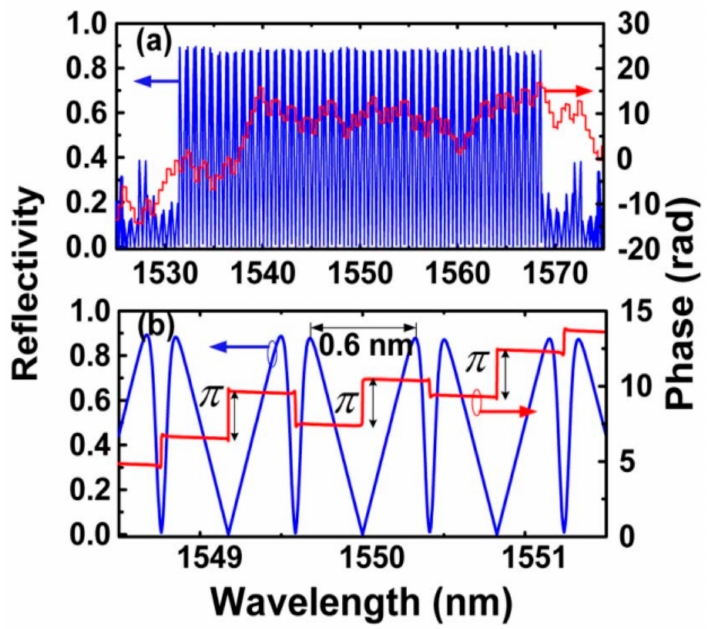
Figure 24. The designed results of the 45-channel first-order temporal differentiator based on a phase-only sampled FBG. ( a ) The full-view of the 45 channels, and ( b ) the zoom-in view of the central three channels. Adapted with permission from ref. [125]. © [2022]